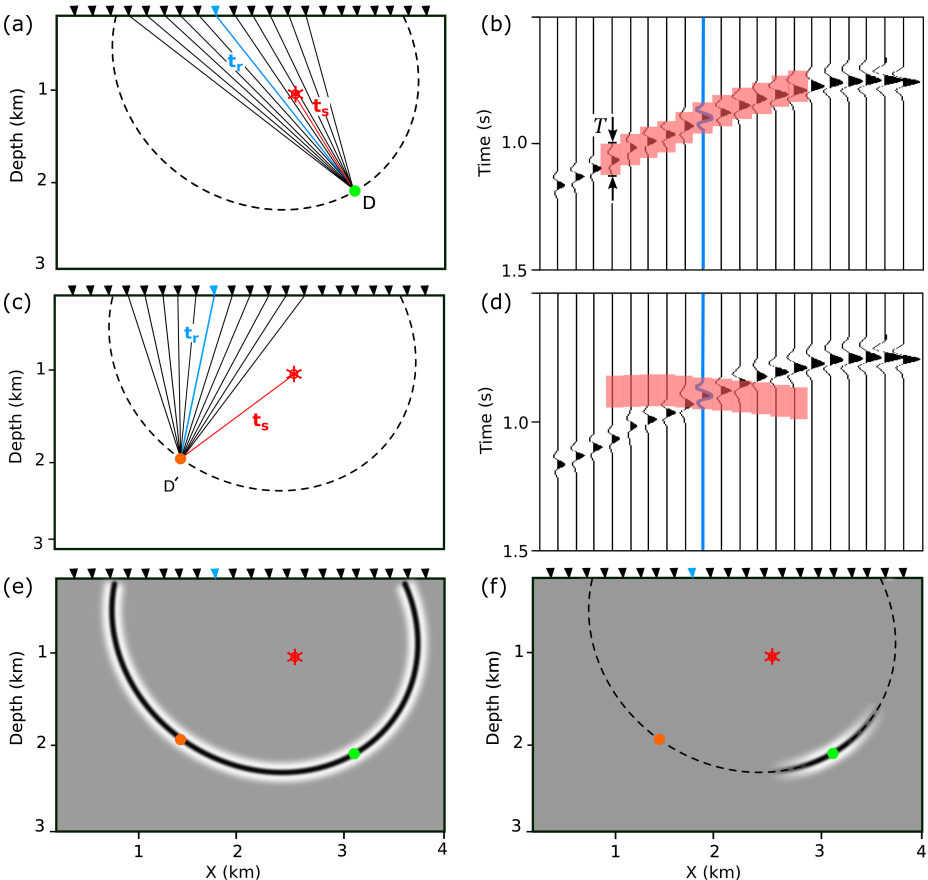
Figure 3. Concept of coherency migration. The red asterisk shows the source position, and the triangles are surface receivers. The red boxes in (b) and (d) are the time windows with the length T defined on the neighbouring traces, with respect to the traveltime of the image point. For detailed description, see